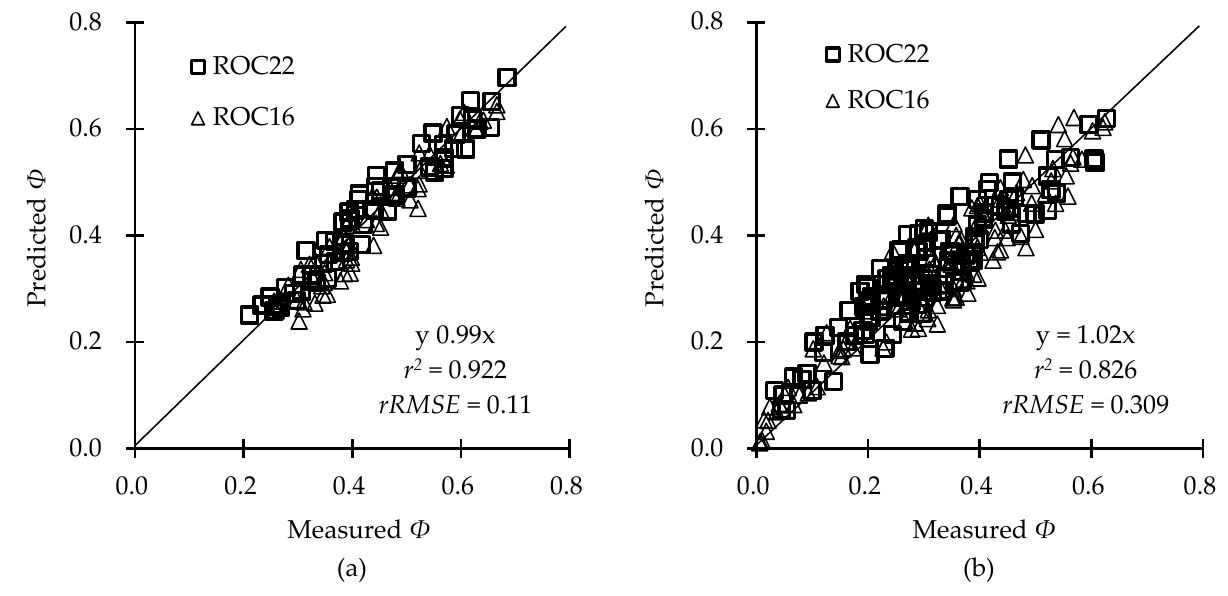
Figure 4. Comparisons between the measured photosynthetic quantum efficiency ( Φ ) and the predicted Φ of the two cultivars under different photothermal ( a ) and drought conditions ( b ).